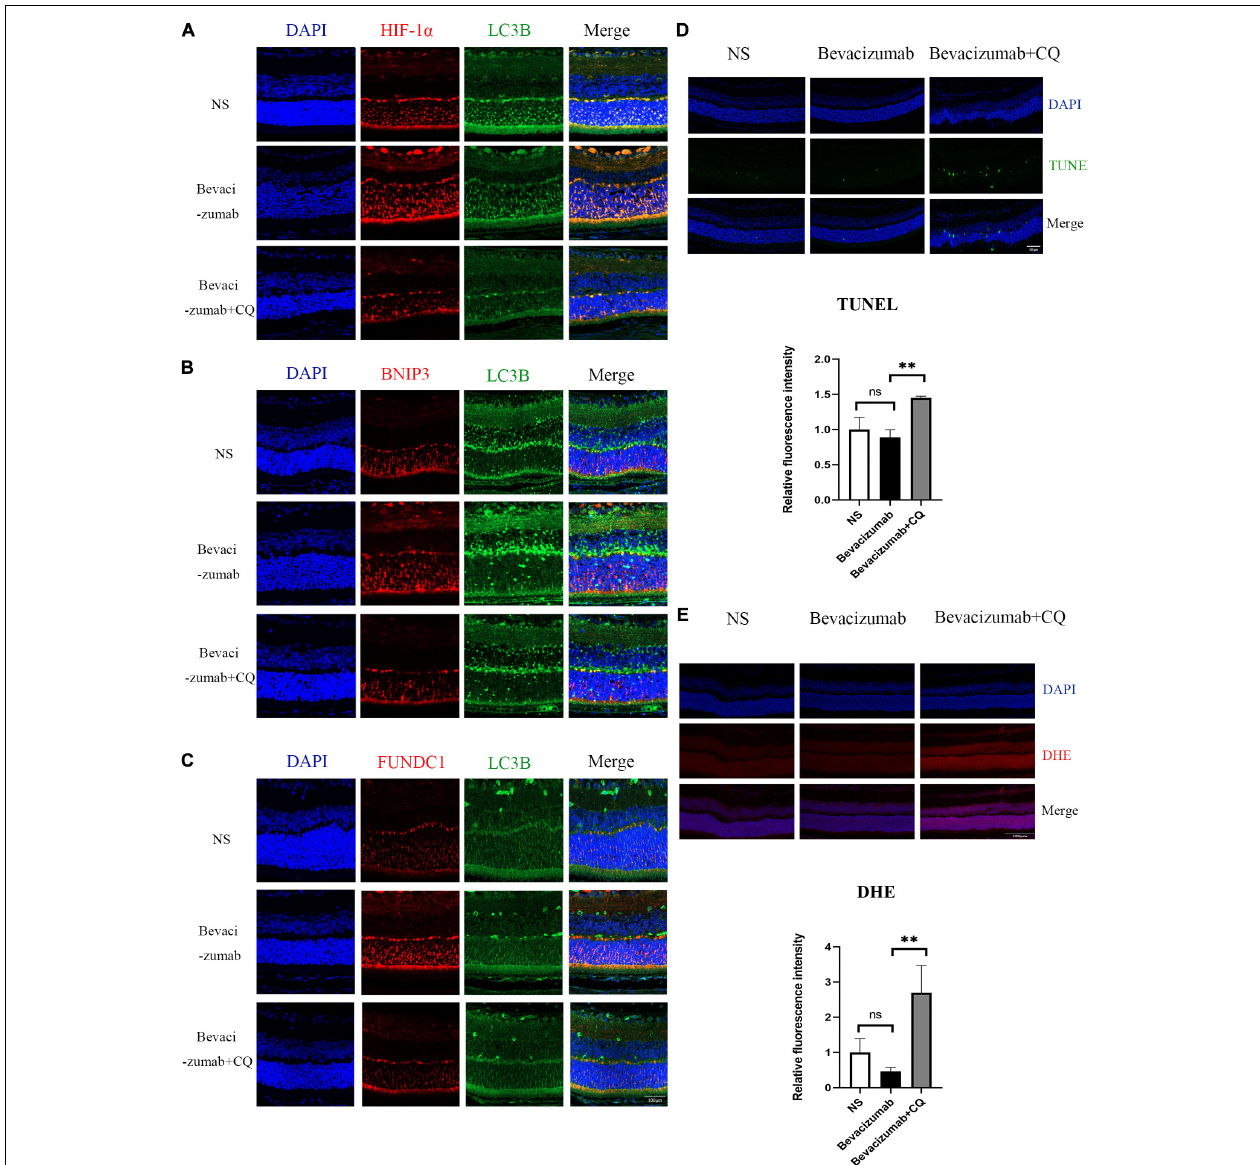
FIGURE 5 | Hypoxia-inducible factor-BNIP3/FUNDC1-mediated mitophagy prevented bevacizumab-induced ROS accumulation and ROS-induced apoptosis in OIR mouse retina: (A–C) OIR mice received intravitreal injection of bevacizumab alone or bevacizumab plus LW6, Representative immunofluorescence images showing LC3 co-staining with HIF, BNIP3, or FUNDC1 in retina of OIR model. (D) OIR mice received intravitreal injection of bevacizumab alone or bevacizumab plus CQ injection, Representative TUNEL staining imaging that CQ suppressed mitophagy and promotes apoptosis in bevacizumab-treated retina. Bar = 100 µ m. (E) Representative fluorescence images showing that CQ interfered with mitophagy and promotes ROS production in bevacizumab-treated retina. Bar:100 µ m. ns: no significance, * P < 0.05, ** P < 0.01, *** P <